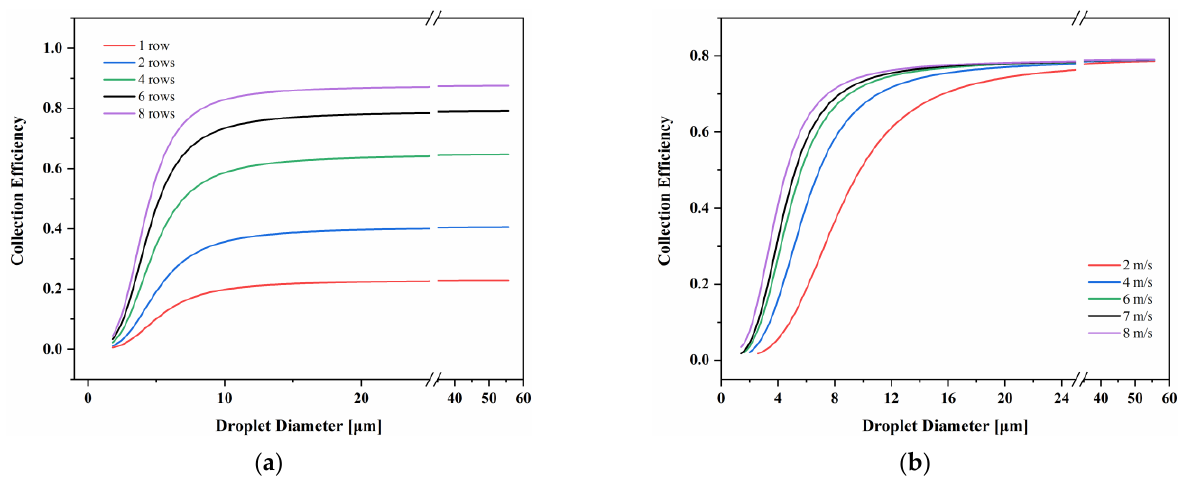
Figure 2. The collection efficiency as a function of droplet diameter at the airspeed of 4 m s − 1 ( a ) and the row number of 6 ( b ).